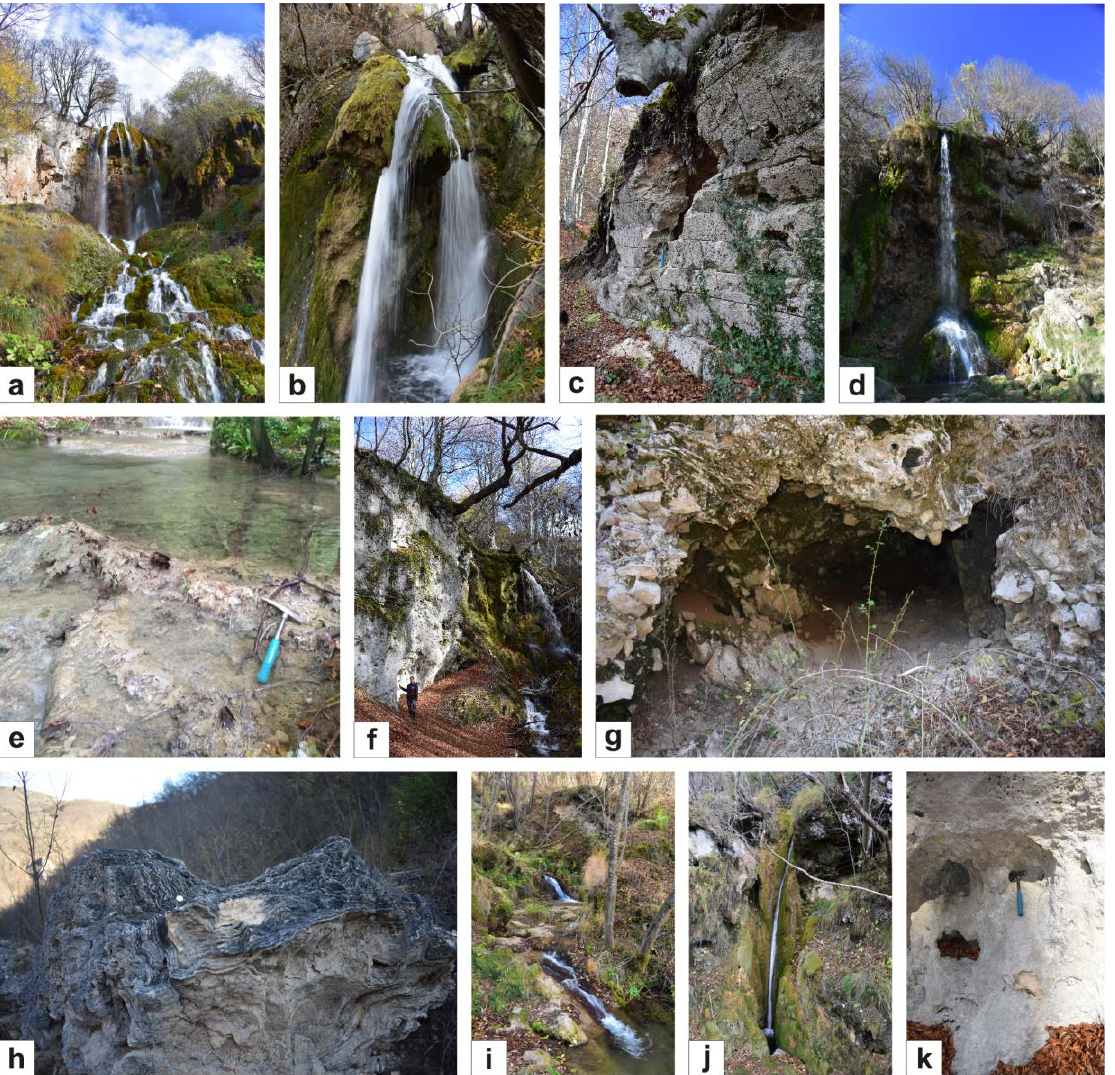
Figure 2. ( a ) The tallest, multi-step waterfall at the River Sopotnica with active tufa precipitation; ( b ) Curtain-type waterfall at the River Sopotnica; ( c ) Fossil tufa, with visible traces of exploitation; ( d ) The main waterfall at Gostiljska River with active tufa precipitation; ( e ) Several tufa barrages surrounding swallow pools; ( f ) Fossil tufa outcrop; ( g ) Limestone fragments mixed with tufa debris; ( h ) Stromatolitic laminated fossil tufa; ( i ) Algae occupying the river bottom; ( j ) “Dry” waterfall; ( k ) Fossil tufa.